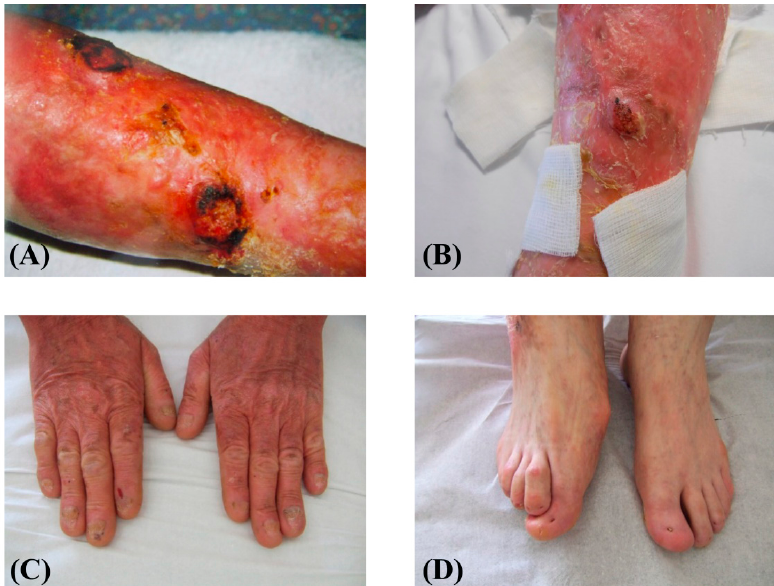
Figure 1. Patient clinical features. ( A ) The skin of the left leg is diffusely erythematous with several blisters, crusts, and two nodular lesions with hyperkeratotic borders, suggestive for squamous cell carcinoma (SCC), and ( B ) the right leg skin shows similar features and a single nodular lesion, also suggestive of SCC; the three nodular lesions were excised and the diagnosis confirmed by histopathology. ( C ) Skin atrophy, dyspigmentation and a few small crusts of the digits and hand dorsum. The fingernails are markedly dystrophic or absent; ( D ) absence of